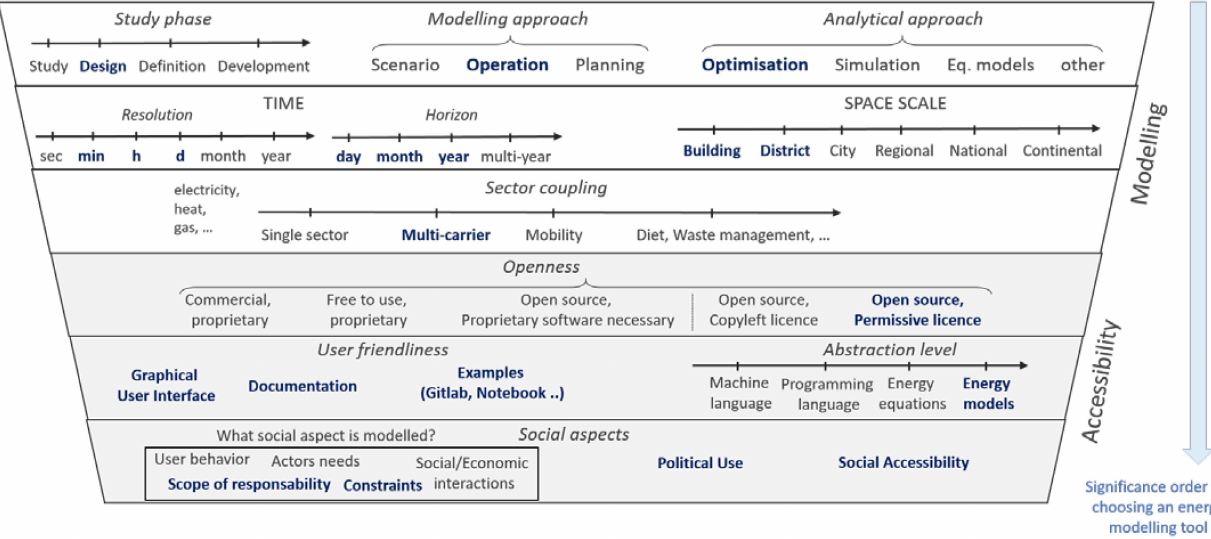
Figure 3. Energy modelling tool characteristics, with OMEGAlpes characteristics in bold blue. Source: